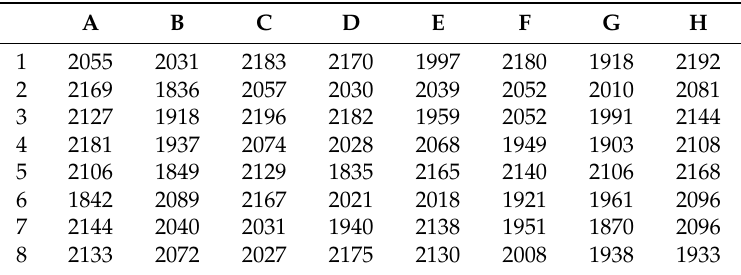
Table 3. FMT results of CO 2 concentration distribution (ppm).